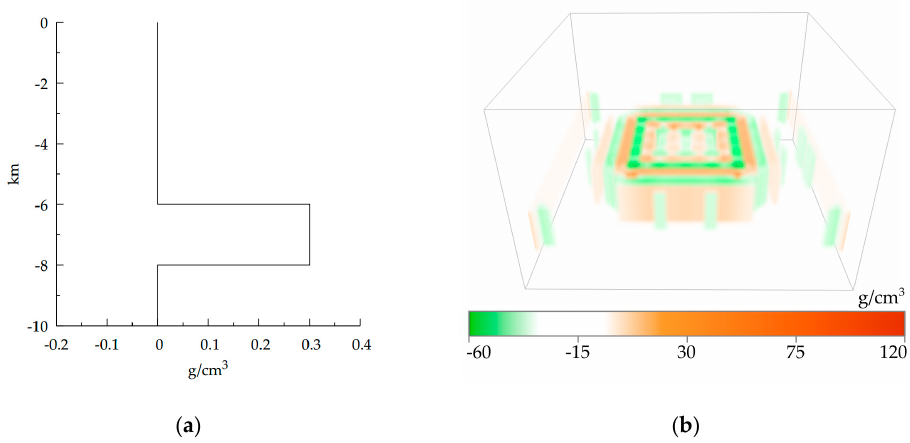
Figure 7. Synthetic example modification #2: ( a ) Background density distribution 𝜌 (cid:2868) (𝑧) and ( b ) Linear problem inverse solution, which is based on it.